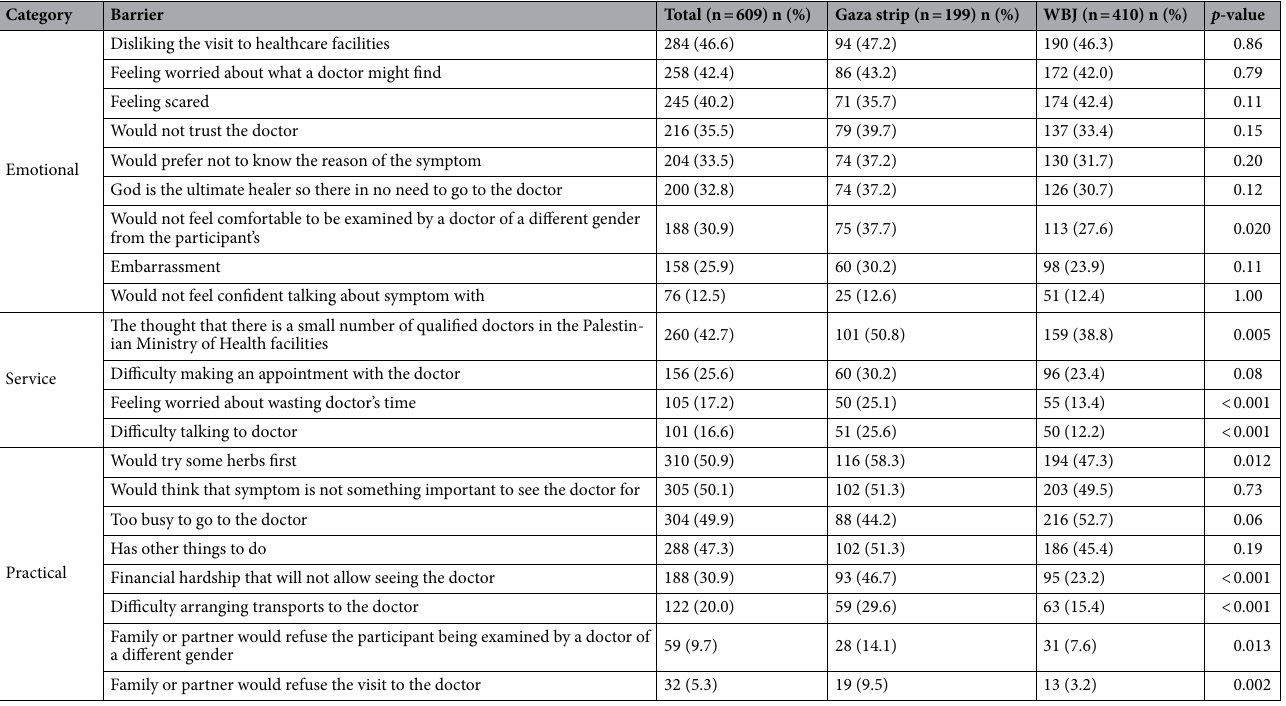
Table 5. Summary of the reported barriers to early presentation among study participants. n = number of participants, WBJ = West Bank and Jerusalem. All p -values are for Pearson’s Chi-square